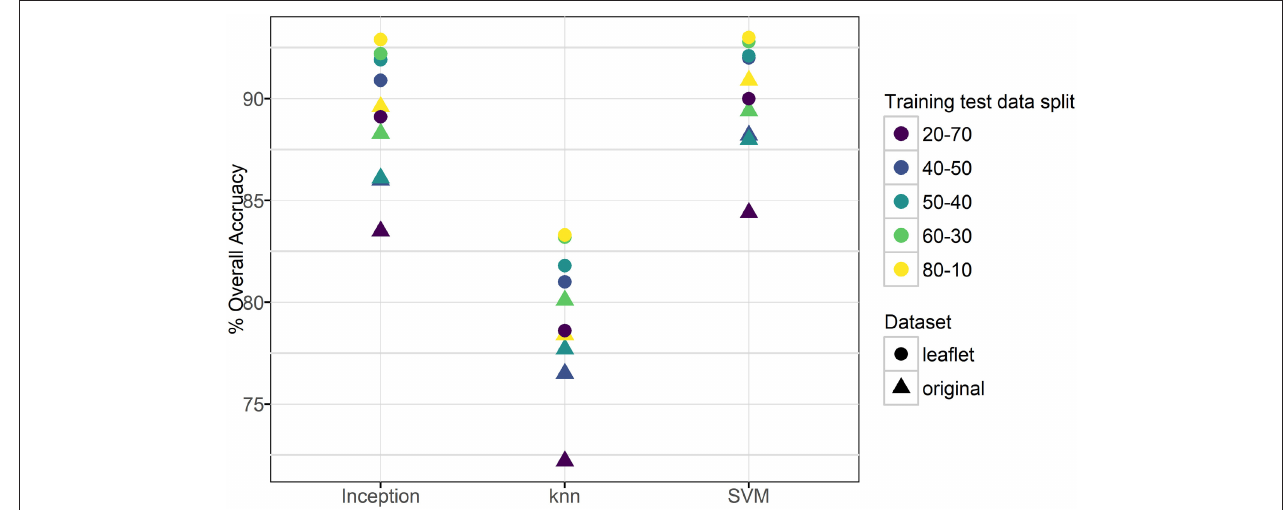
FIGURE 3 | Overall accuracy for transfer learning using three machine learning